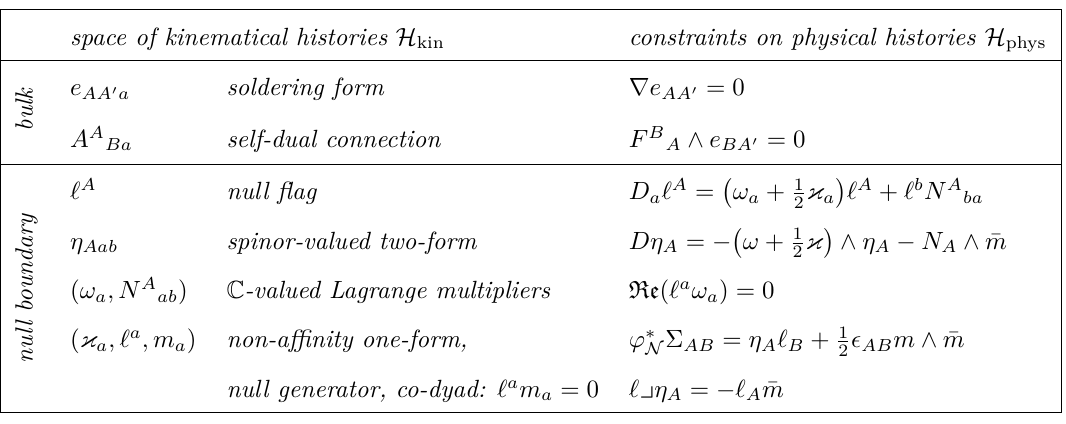
Table 1 . On the space of kinematical histories H kin , there is no correlation between the boundary fields and the fields in the interior of the manifold. The correlation is established on the space of physical histories H phys , which consists of all solutions of the bulk plus boundary field equations: there are the Einstein equations and the torsionless condition in the bulk, but there are also addi- tional constraints at the boundary (boundary field